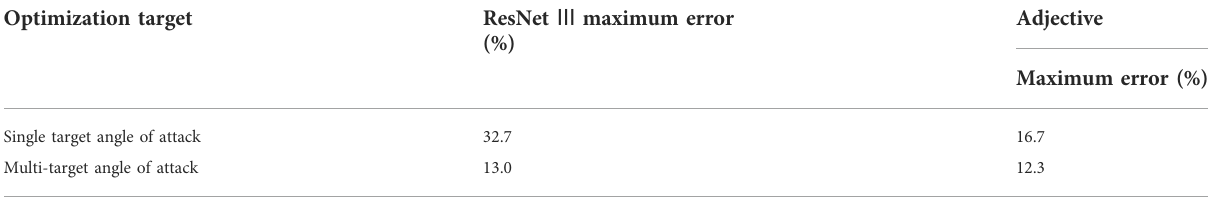
TABLE 2 Single network (ResNet Ⅲ ) and multi-network collaboration (Adjective) optimize the angle of attack of single and multi-target. The maximum error between the predicted value of the lift-to-drag ratio of the network participating in the optimization and the predicted value of the result of the independent reference network CNN Ⅲ .